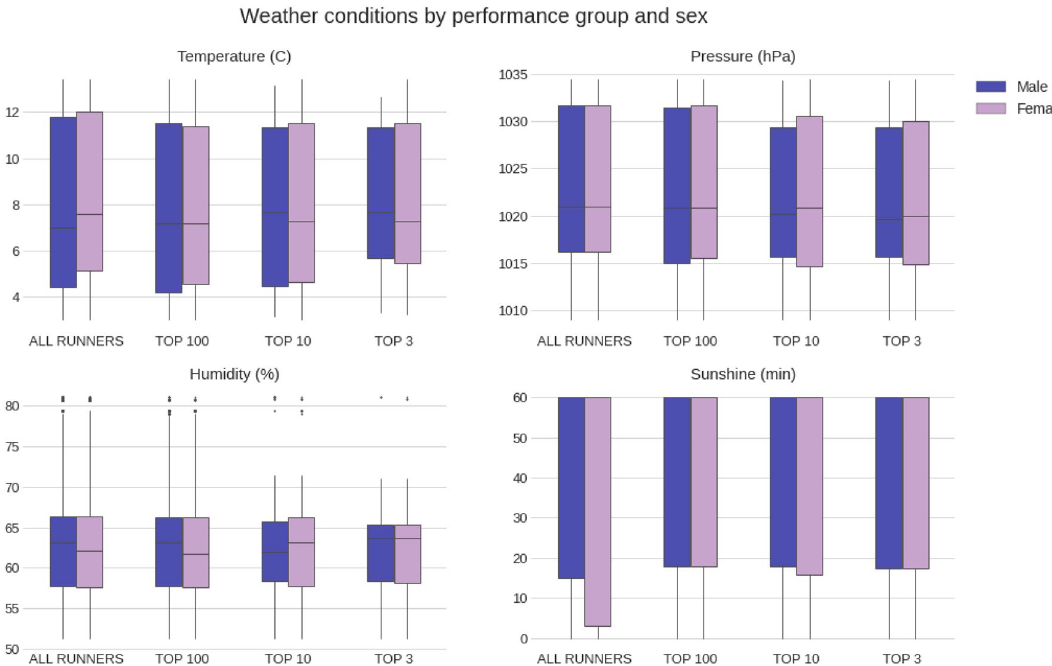
Figure 4. Weather conditions by performance group and sex.